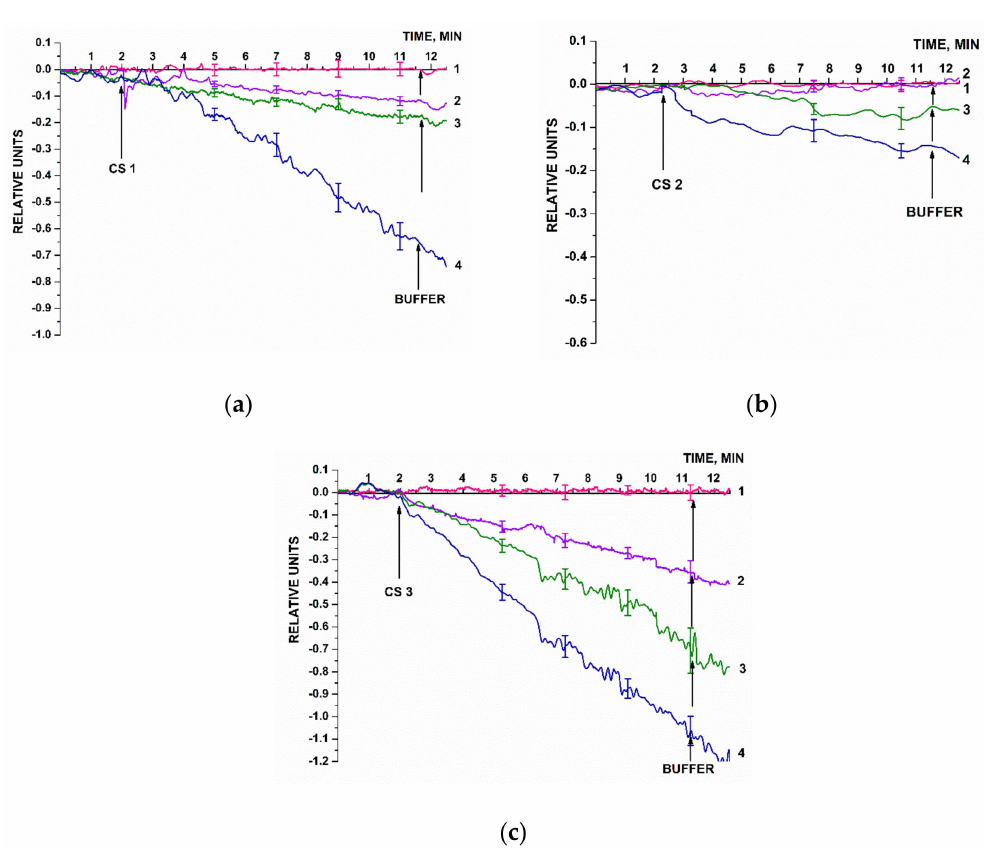
Figure 7. Typical sensogram curves recorded upon the biosensor-based detection of synthetic oDNA analogues of target miRNAs, oligonucleotides CS 1 ( a ), CS 2 ( b ), and or CS 3 ( c ) in buffer solutions. Experimental conditions: SOI-NW chip with n-type conductivity; nanowires were sensitized with oDNA probes (probe_1, probe_2, and probe_3); 1 mM PPMB, V g = 50 V, V ds = 0.2 V; solution volume in the measuring cell was 450 µ L. Concentrations of the solutions of oDNA targets in the cell were